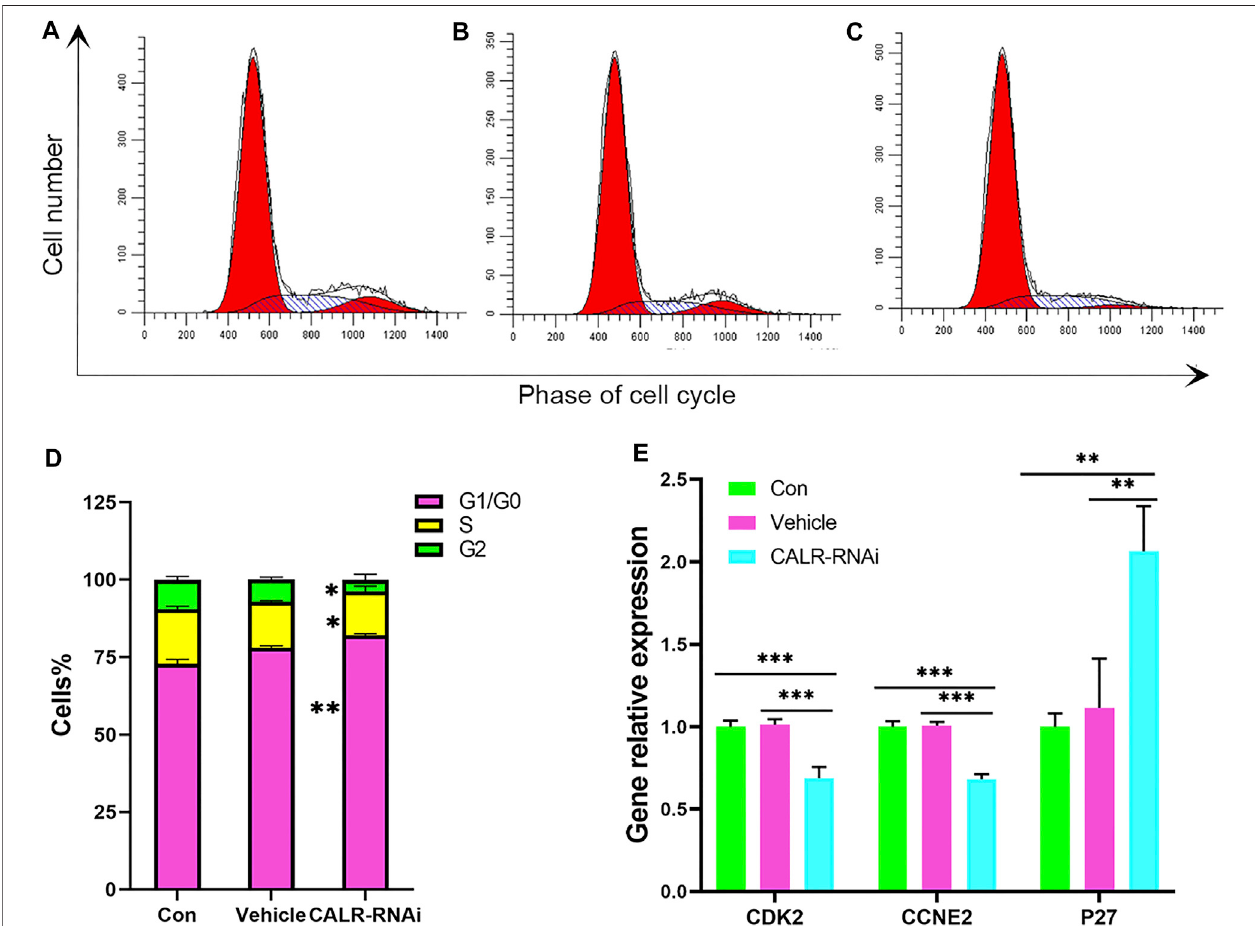
FIGURE 9 | Effects of CALR downregulation on the AcPP cell cycle. (A – C) Cell cycle distribution of the AcPP cells after 24 h of culture. (D) Bar graphs depict the proportions of different phases (G1, S, and G2) accounting for each cell cycle after 24 h of culture; it is to be noted that CALR downregulation resulted in signi fi cant changesinthephasedistribution.* p < 0.05and** p < 0.01. (E) mRNAexpressionpro fi lesofcellcycleregulatorygenes,P27,CDK2,andCCNE2inthecontrolandCALR downregulated AcPP cells; it is to be noted that the cell cycle inhibitory gene (P27) was upregulated, whereas promoting genes (CDK2 and CCNE2) were downregulated. ** p < 0.01 and *** p <